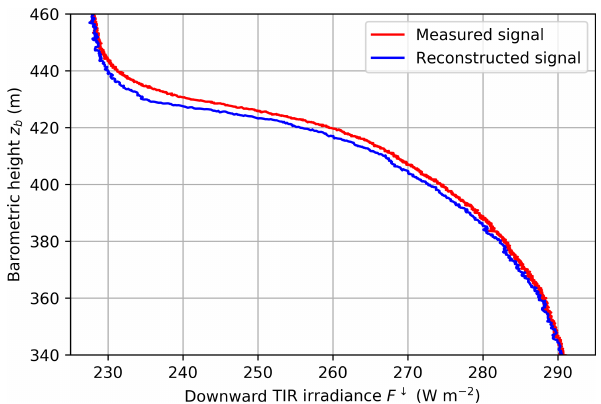
Figure 8. Vertical profile of downward TIR irradiance measurement on 5 June 2017 (red) in the cloud top region. The blue line displays the reconstructed